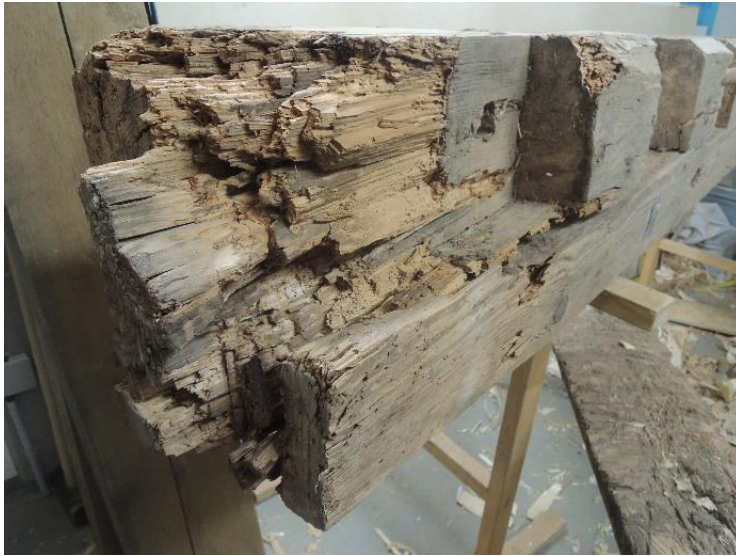
Figure 2. Damage to beam (III) at the bottom .